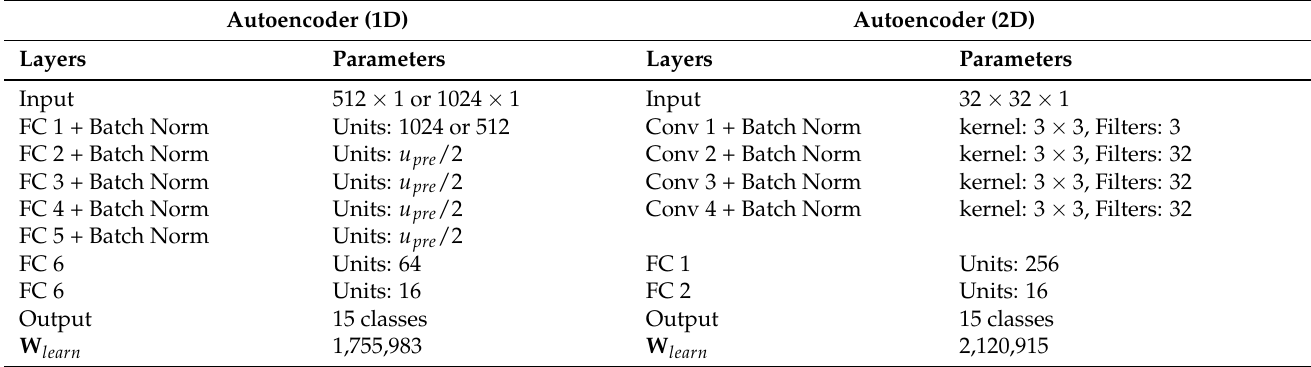
Table 2. Structural details for the AE, SAE and DAE models. As SAE and DAE are structurally similar to AE only details for AE are